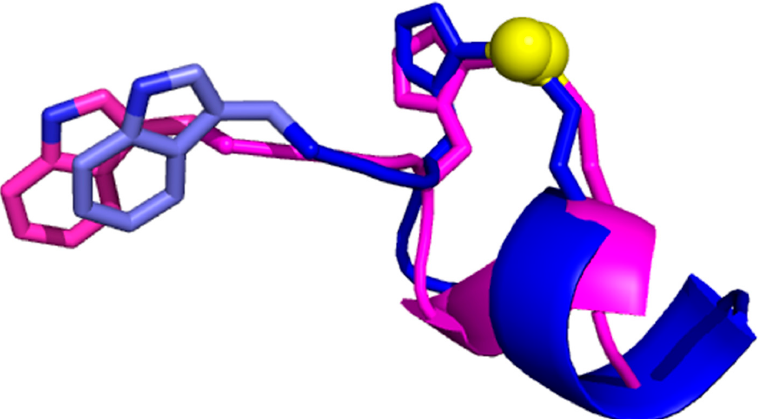
Figure 3. Structural superposition of two zinc-binding fragments containing the HX(2)C sub-pattern, found in PARP ( blue ) and PHD ( magenta ) zinc-finger domains. The Trp residues located in the second position before the His ligand ( i.e. , WXHX(2)C) are shown as sticks. The zinc ions are shown as yellow spheres; the zinc-binding residues are shown as sticks.